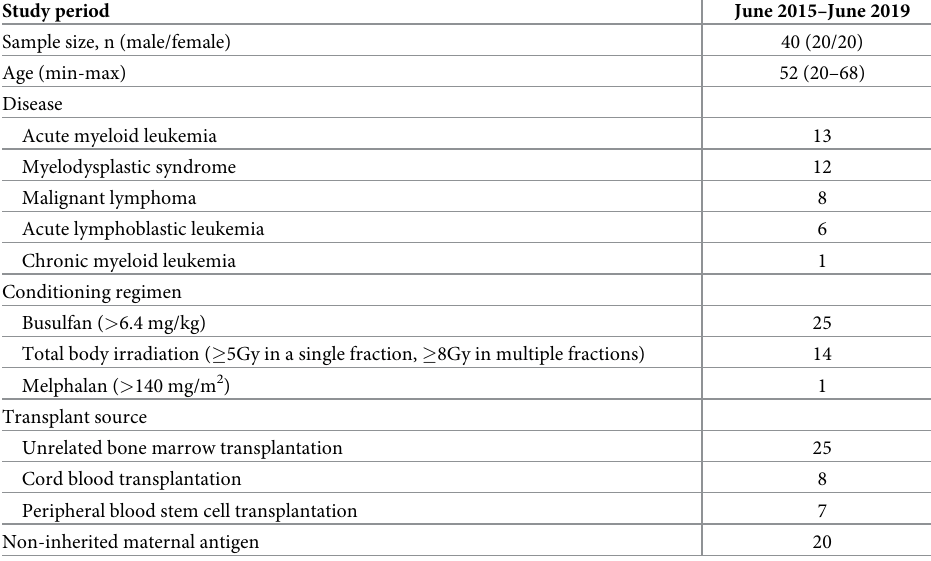
Table 3. Patient